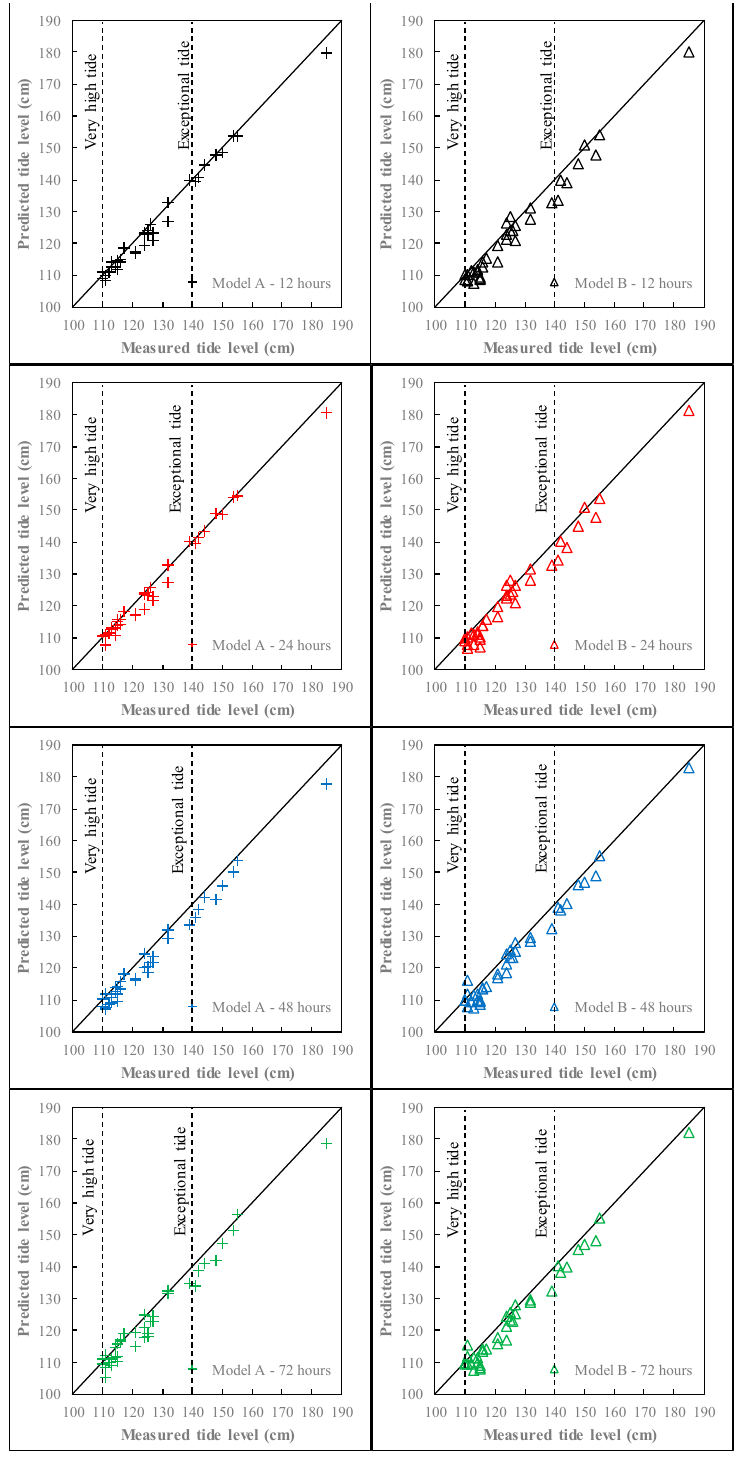
Figure A2. Comparison between measured and predicted storm tide for different lag times—Ensemble model.